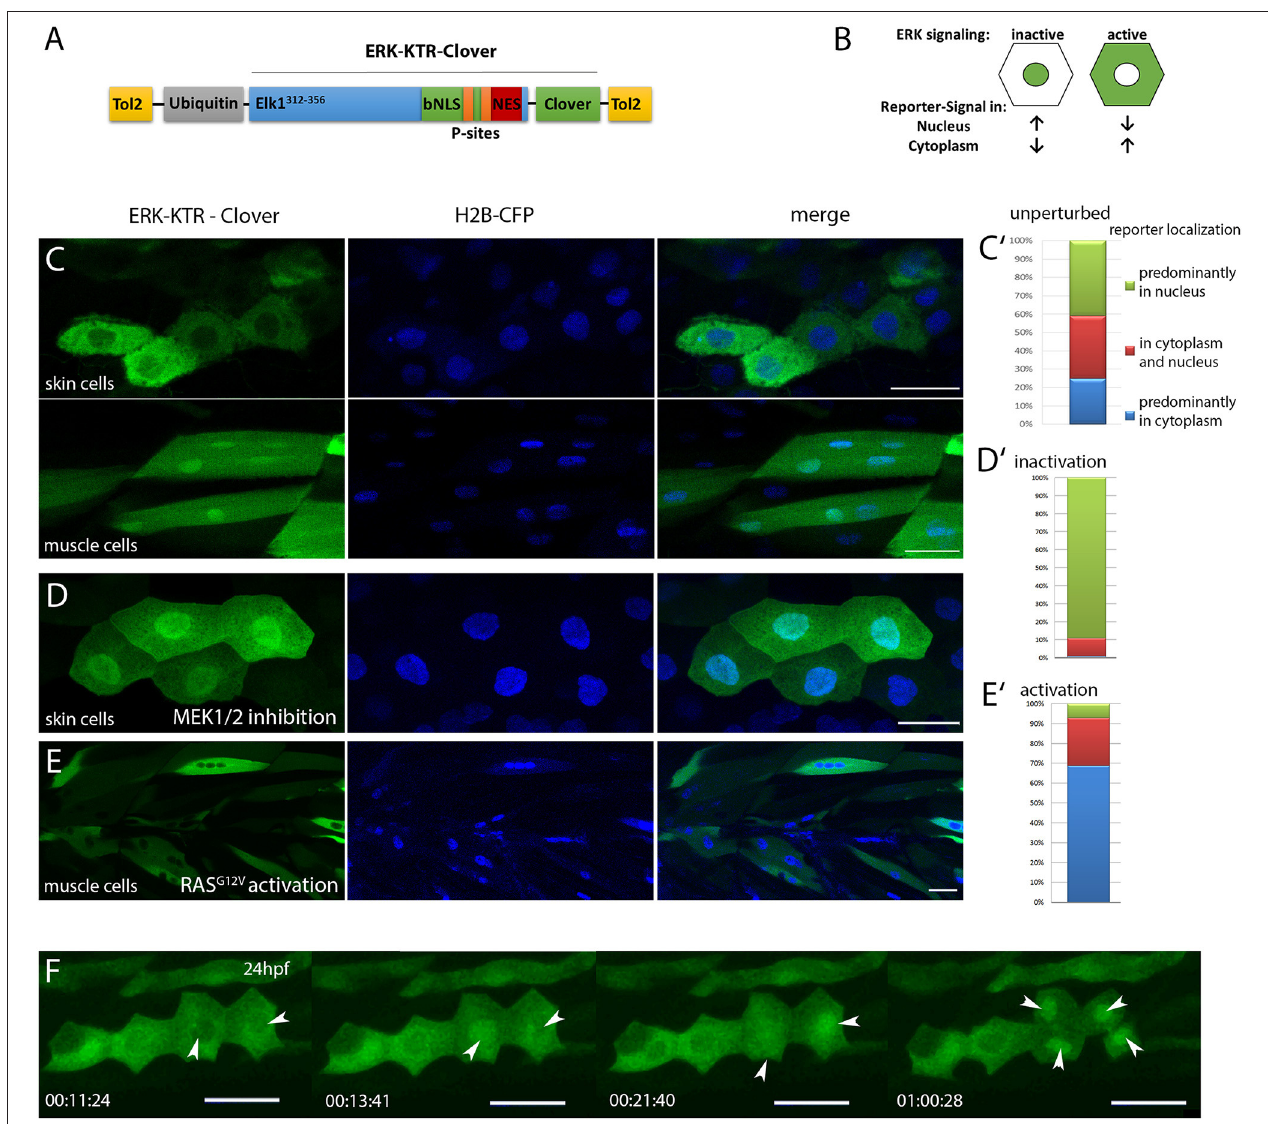
FIGURE 1 | Characterization of ubi:ERK-KTR-Clover in zebrafish embryos. (A) Schematic illustration of the DREKA transgenesis vector pDESTubi:ERK-KTR-CloverpATol2. (Tol2, Tol2 recombinase recognition sites; ubiquitin, ubiquitin promoter; Elk1 312 − 356 , ERK docking sites from Elk1; bNLS, bipartite nuclear localization signal; P-sites, phosphorylation sites; NES, nuclear export signal; modified after Regot et al., 2014) (B) Schematic depiction of the ERK-KTR reporter principle. ERK signaling inactive: reporter is mainly localized in the nucleus; ERK signaling active: reporter is localized in the cytoplasm sparing the nucleus. (C) pDESTubi:ERK-KTR-CloverpATol2 and H2B-CFP mRNA co-injected wildtype zebrafish embryos express ERK-KTR-Clover in a mosaic manner. mClover fluorescence is mainly found in the cytoplasm of skin epithelial cells, indicating active Erk signaling (upper panel) and in the nucleus of muscle cells indicating absence of Erk signaling activity (lower panel). (C ′ ) Quantification of ERK-KTR localization in skin epithelial cells and muscle cells at 48 hpf. Green, mClover fluorescence in the nucleus; Red, mClover fluorescence distributed throughout the cell; Blue, mClover fluorescence in the cytoplasm sparing the nucleus ( n = 385 cells, 10 embryos at 48 hpf). (D) Skin epithelial cells of co-injected embryos incubated with MEK1/2 inhibitor PD98059 (30 µ M) overnight show mClover fluorescence in the nucleus at 48 hpf indicating the reporter responds to Mek inhibition. (D ′ ) Quantification of mClover localization shows reporter shuttling to the nucleus after MEK1/2 inhibition ( n = 300 cells, 5 embryos at 48 hpf). (E) Muscle cells expressing constitutively active HRAS (zebrafish injected with pDESTubi:ERK-KTR-CloverpATol2, H2B-CFP:UAS:HRASG12V, and KalTA4 mRNA Distel et al., 2009) show active Erk signaling at 48 hpf. (E ′ ) Quantification of mClover localization shows constitutively active HRAS induced reporter shuttling to the cytoplasm ( n = 235 cells, 5 embryos at 48 hpf). (F) Mitotic skin epithelial cells of pDESTubi:ERK-KTR-CloverpATol2 injected zebrafish at 24 hpf. Dividing skin epithelial cells (white arrowheads) show dynamic Erk signaling with a sudden change from cytoplasmic to nuclear reporter localization before cytokinesis [compare time points 11:24 min/13:41min (left arrowhead) and 13:41 min/21:40min (right arrowhead)]. After cytokinesis the reporter remains in the nuclei of both daughter cells (arrowheads at 1:00:28h). Images taken from a time-lapse movie ( Movie 2 ) are maximum projections of several planes. All scale bars are 25 µ m. All images were recorded on a Leica SP8 X WLL confocal microscope and rendered using Photoshop CS6.